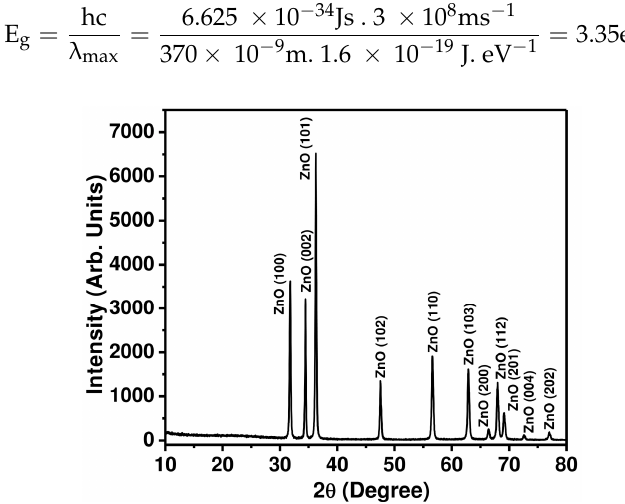
Figure 2. Typical XRD pattern for the as-synthesized ZnO nanopeanuts.